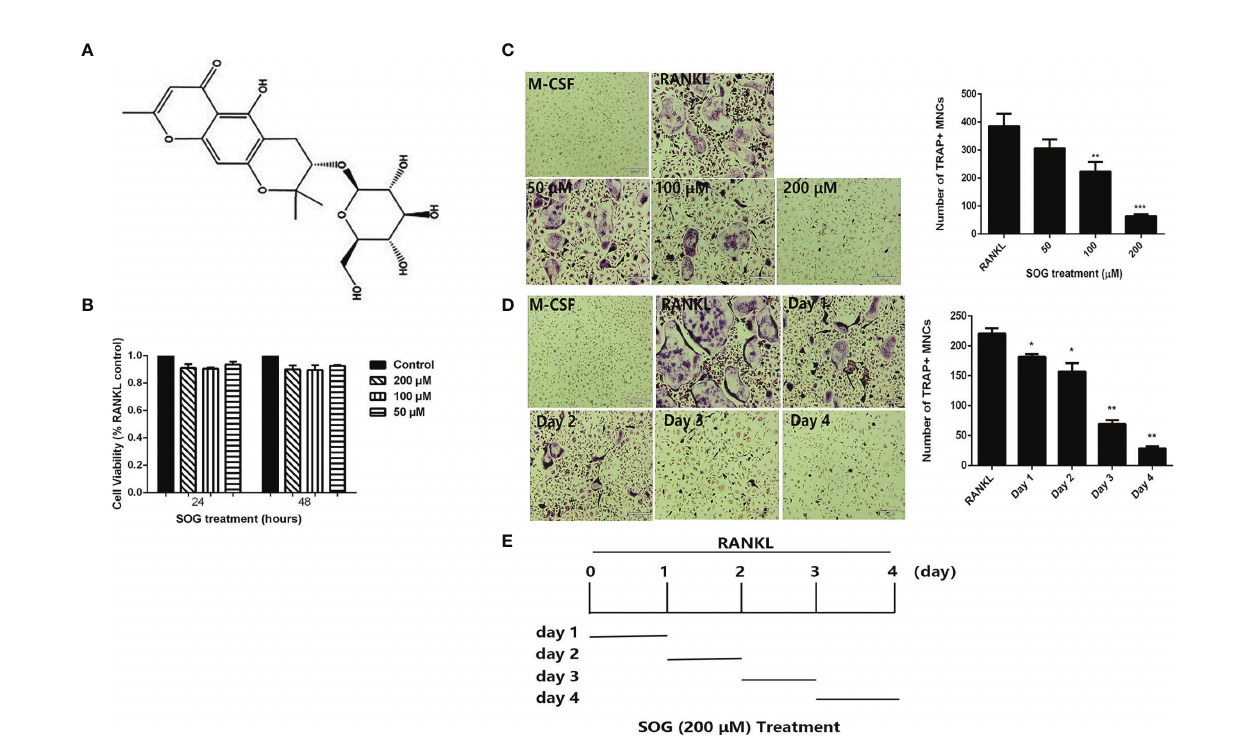
FIGURE 1 | SOG inhibits RANKL-induced osteoclastogenesis. (A) Chemical structure of Sec-O-glucosylhamaudol (SOG). (B) Cell viability of BMMs cultured with M-CSF, RANKL, and indicated concentrations of SOG, as determined by the MTT assay. (C) TRAP staining of BMMs cultured for 4 d with M-CSF, RANKL, and different concentrations of SOG. (D) TRAP staining of RANKL-stimulated BMMs treated with 200 m M SOG for one day at different stages of cell culture. Magni fi cation: 100×, Scale bar: 190 m m. TRAP + multinucleated cells with ≥ 3 nuclei were regarded as osteoclasts. (E) SOG treatment time for (D) . All experiments were performed in duplicate at least three times, * p < 0.05, ** p < 0.01 and *** p < 0.001 versus RANKL-positive